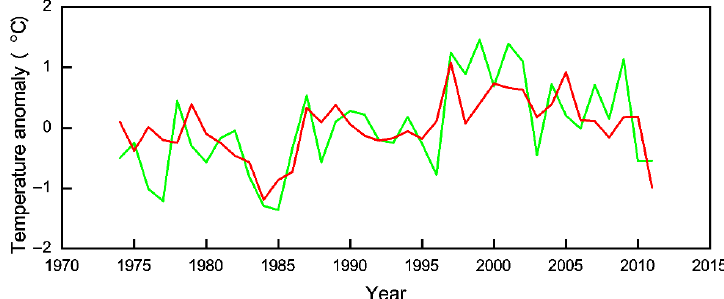
Figure 4. A comparison between the observed (green) and reconstructed (red) T DS . Table 3. Verification results of the canonical methods for the reconstruction.